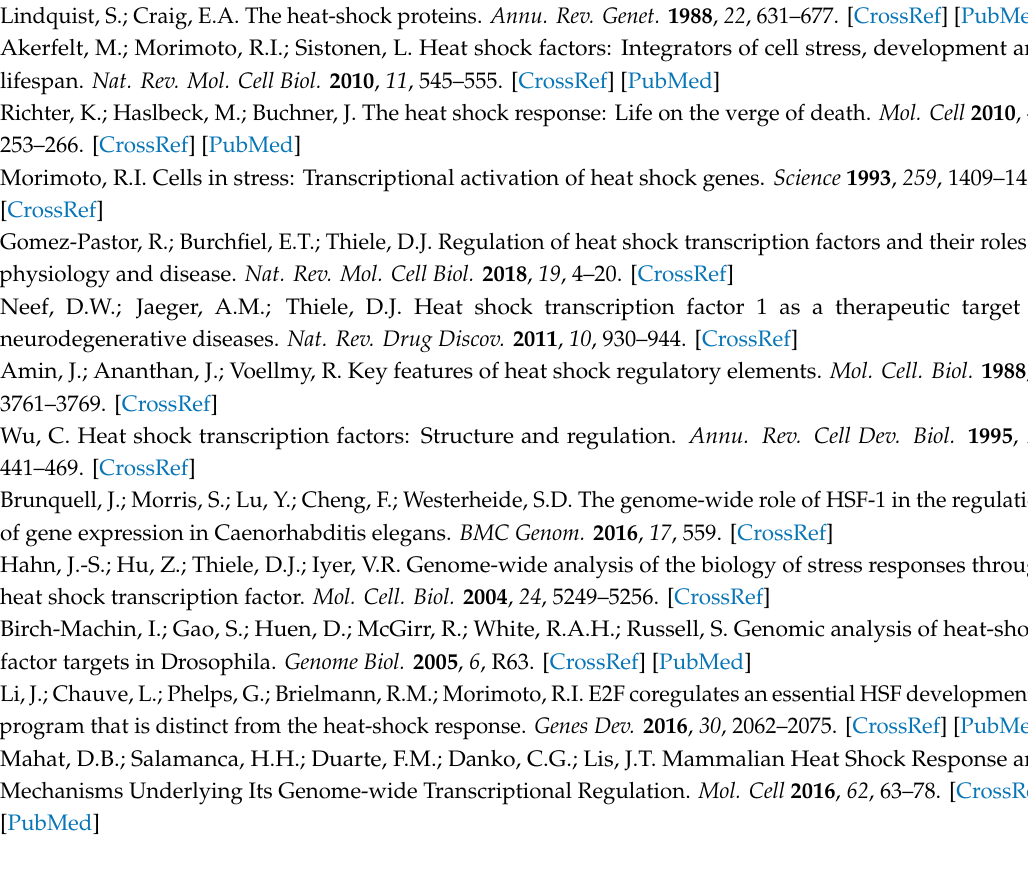
Table S10: HSF-1 target genes related to ageing in mice. ‘All mouse HSF1 targets’: List of all mouse HSF1 target genes related to ageing according to the GenAge database. ‘Directly regulated HSF1 targets’: List of mouse ‘HSF1 targets with evidence for direct interaction and HSF1 dependent regulation’ (see: Table 1) according to the GenAge database. Table S11: PANTHER analyses of conserved and unique HSF1 target genes in groups vertebrate and non-vertebrate. ‘Vertebrate’: PANTHER analyses of conserved and unique HSF1 target genes in the examined vertebrate species. ‘Non-vertebrate’: PANTHER analyses of conserved and unique HSF1 target genes in the examined non-vertebrate species. Table S12: HSF1 target genes related to ageing by organism and tissue / cell type. ‘Human’: List of HSF1 target genes related to ageing in human. ‘Mouse’: List of HSF1 target genes related to ageing in mouse. ‘Worm’: List of HSF1 target genes related to ageing in C. elegans . ‘Fly’: List of HSF1 target genes related to ageing in D. melanogaster . ‘Yeast’: List of HSF1 target genes related to ageing in S. cerevisiae . Author Contributions: Conceptualization, J.B., and D.F.; methodology, J.B. and D.F.; software, D.F., and B.B.; formal analysis, B.H., and V.D.; investigation, D.K., T.S. and B.H.; resources, T.V.; data curation, T.S.; writing and original draft preparation, J.B. and T.V.; writing and review and editing, D.K., T.S., B.H., V.D., J.B. and T.V.; visualization, B.H.; funding acquisition,